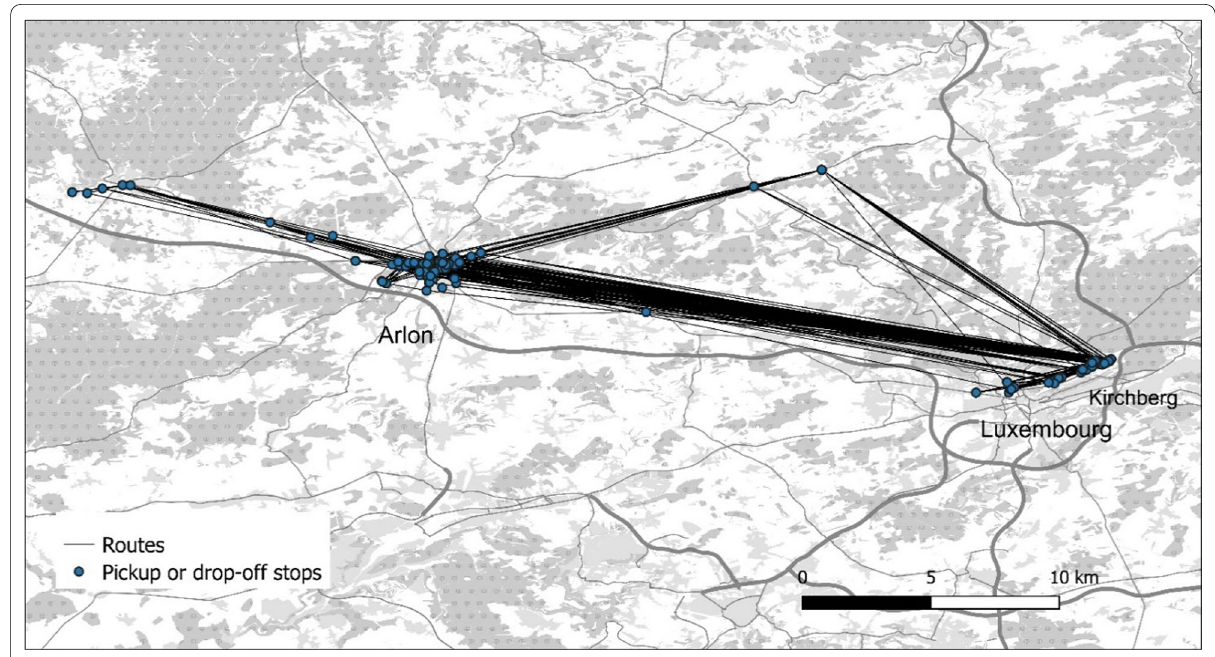
Fig. 1 Kussbus operating routes from Arlon region to Luxembourg City